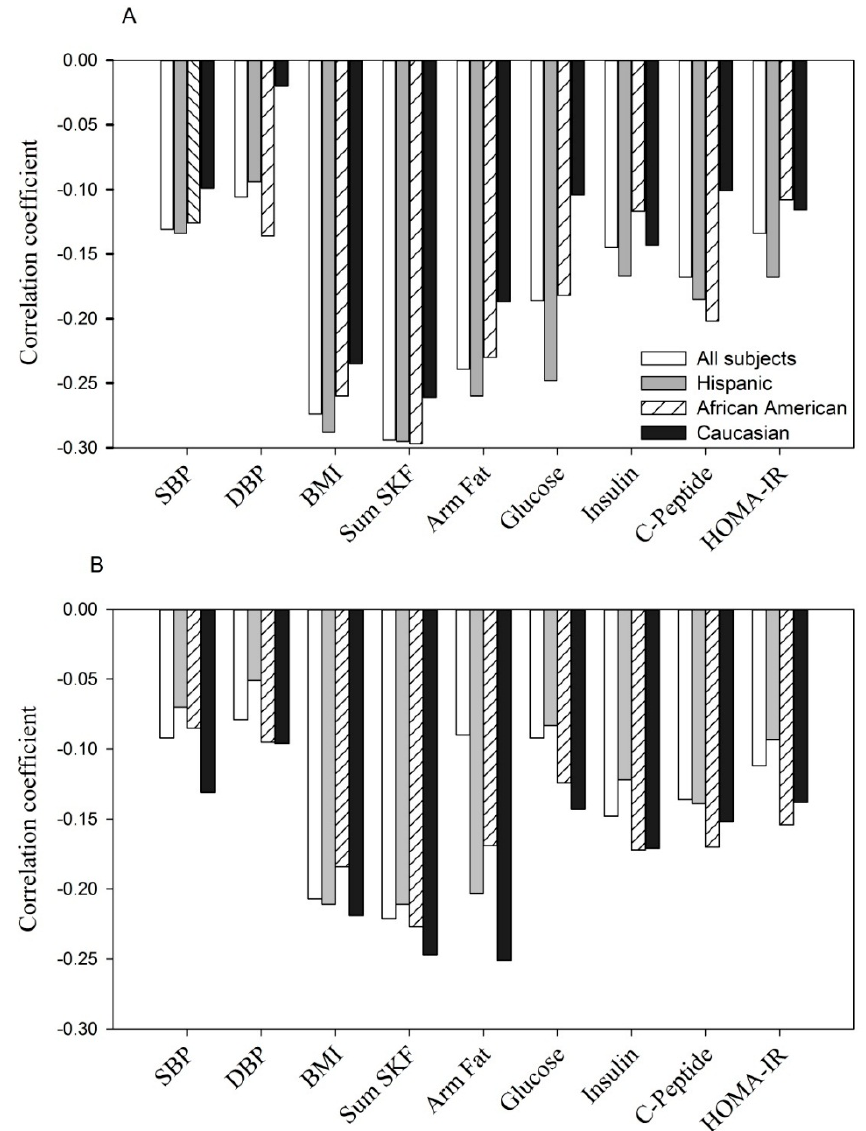
Figure 1. ( A , at entry; B , during the 3rd trimester). The relationship between serum adiponectin (µg/mL) with anthropometric and glycemic parameters. SBP, systolic blood pressure; DBP, diastolic blood pressure; Sum SKF, sum of skinfolds; Arm fat, upper arm fat area; HOMA-IR, the homeostatic model assessment of insulin resistance (same as in Figures 2 and